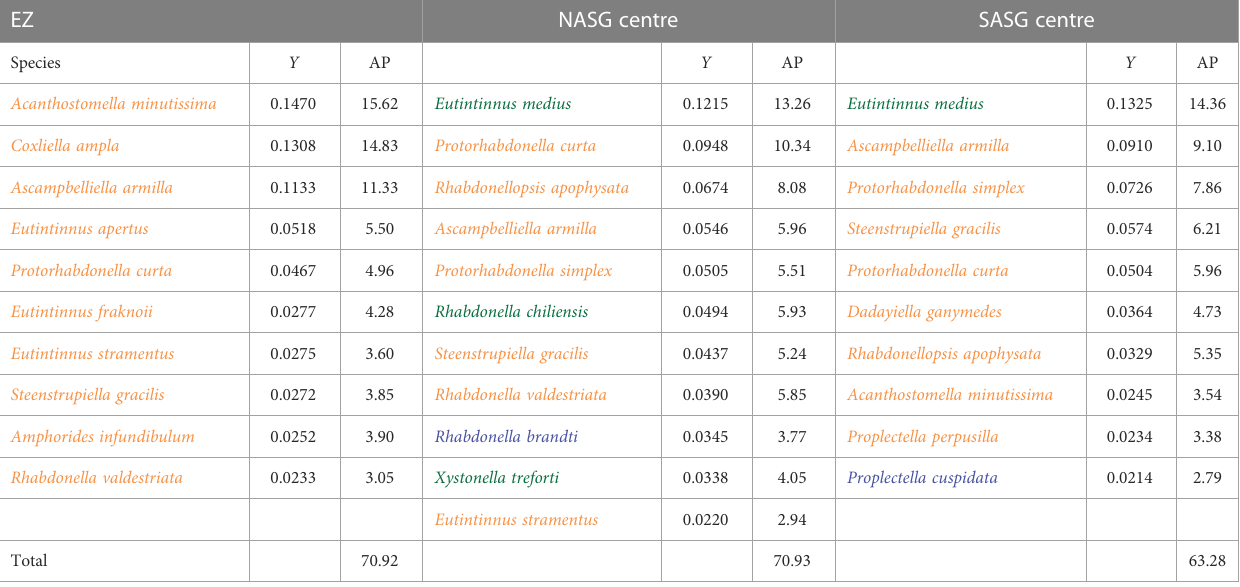
Orange color: Equatorial species; Green color: Gyre species; Blue color: Frontal